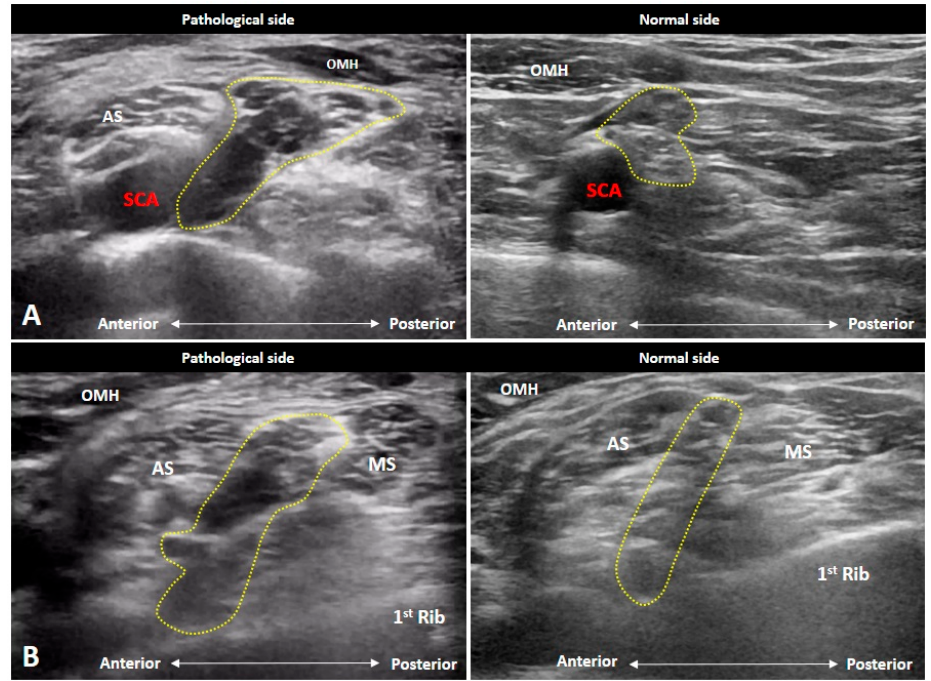
Figure 11. Ultrasound imaging of metastatic brachial plexopathy. The nerve fascicles (yellow dashed area) at the trunk level ( A ) and intertubercular groove ( B ) are enlarged secondary to the tumor infiltration. Like elsewhere, side-to-side comparison is contributory. AS: anterior scalene muscle; MS: middle scalene muscle; OMH: omohyoid muscle; SCA: subclavian artery.